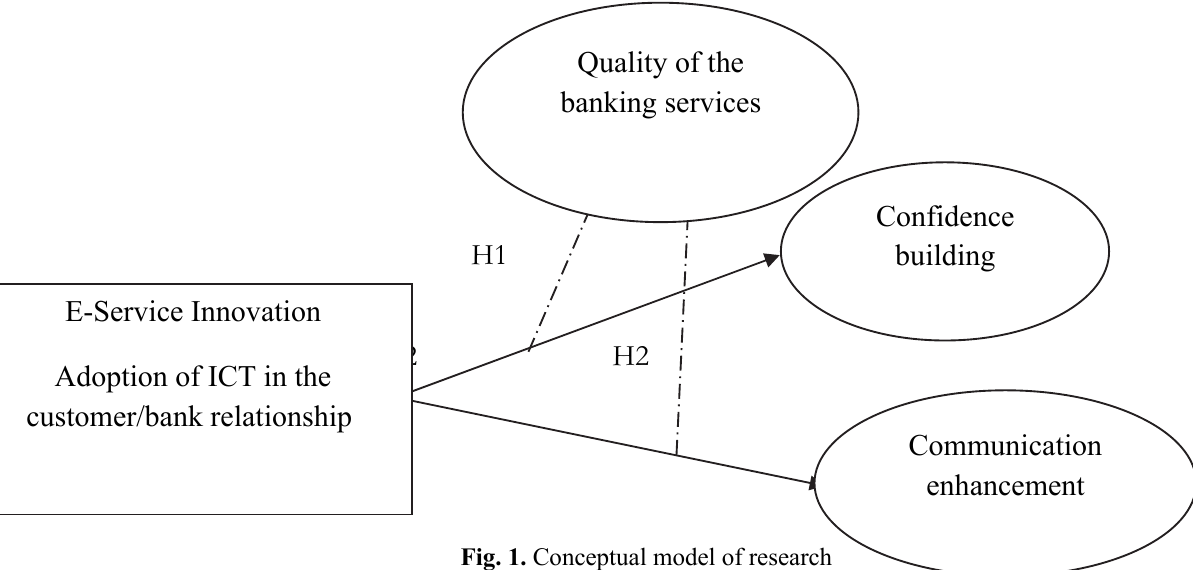
Fig. 1. Conceptual model of